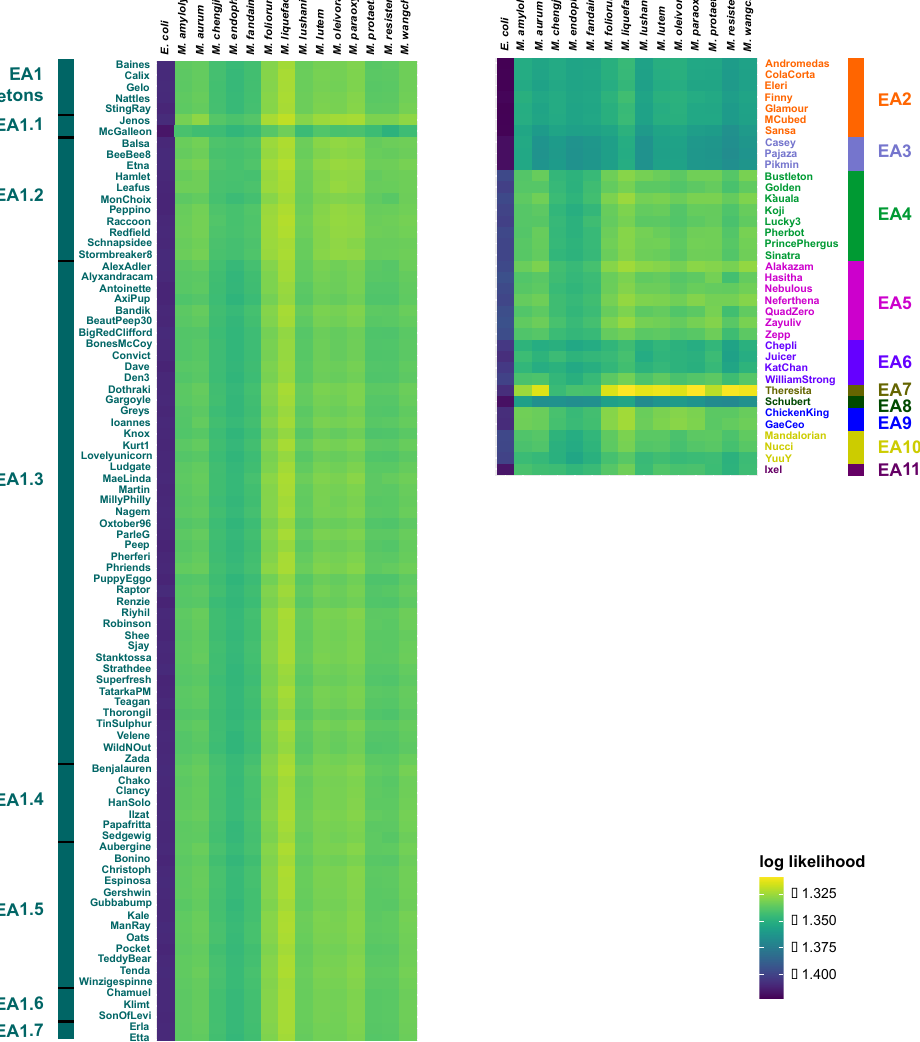
Figure 3. Predicted host ranges. Heatmap of log likelihoods of bacteriophage–host pairs, including 125 cluster EA bacteriophages (Supplementary Table S1), 14 potential Microbacterium host species (Supplementary Table S2), and Escherichia coli as a negative control as predicted by WIsH. Colored names and bars highlight bacteriophage membership in sub-cluster EA1–EA11 groupings in the neighbor-joining tree (Figure 1); higher values in the heatmap correspond to more likely bacteriophage-host interactions.